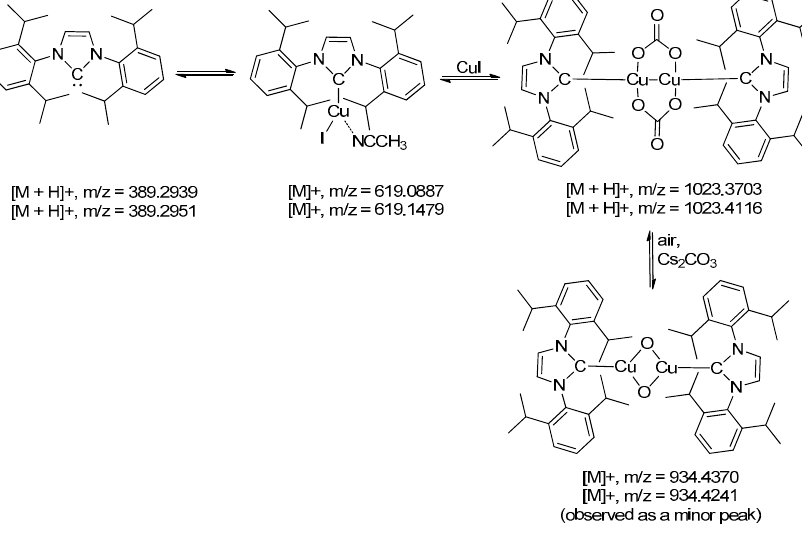
Figure 14. HRMS analysis of the reaction mixture (IPrHCl: CuI = 1:1).